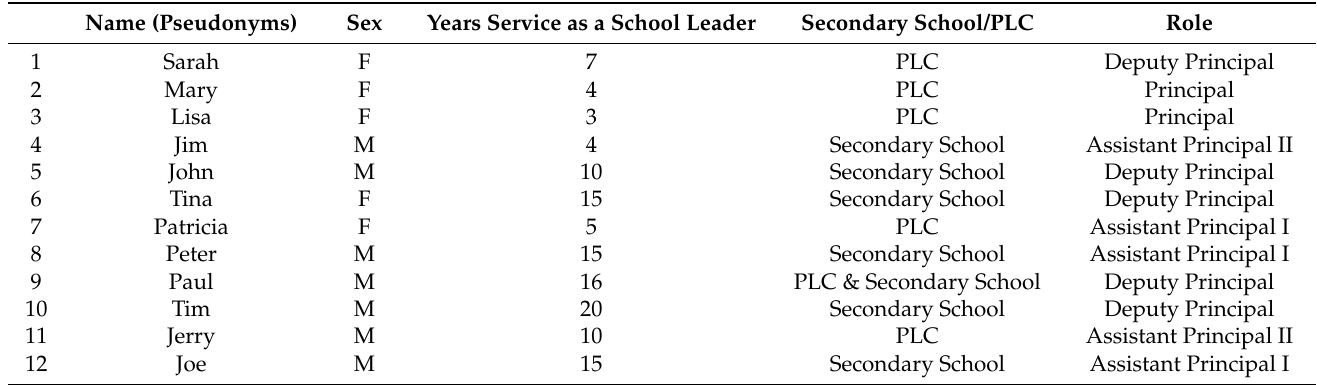
Table 1. Participant Profile